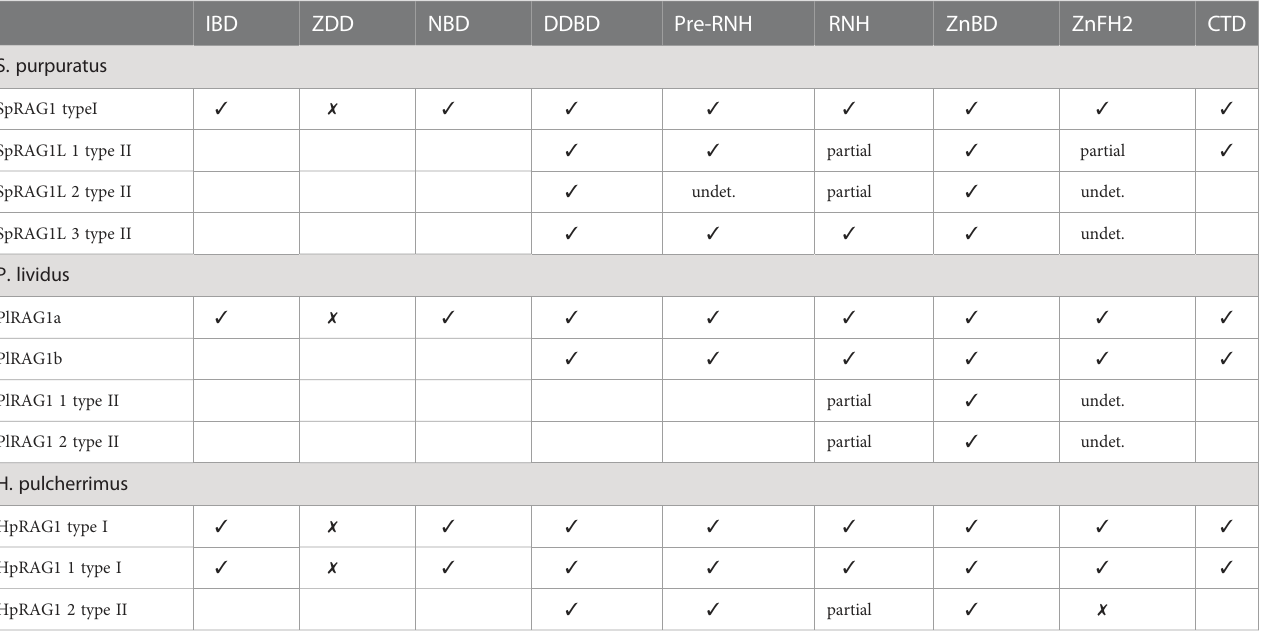
(Figure 5A). PlRAGL1a (type I) showed 95% of translated protein sequence coverage and 50% sequence identity compared to only 56% sequence coverage and 50% identity for PlRAGL1b to the SpRAG1l protein sequence. While PlRAGL1a seems to include all mentioned domains as in SpRAG1L, its N-terminal 1- 159 aa sequence, which includes the ZDD, showed a lower degree of conservation (29% aa identity) (Figure 5A). On the other hand, the